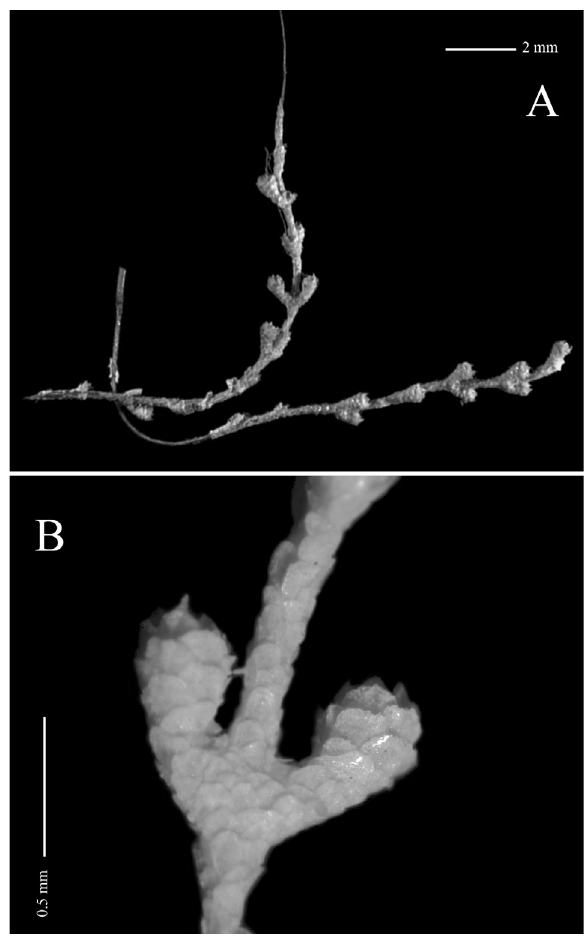
Fig . 15. – Thouarella vitjaz n. sp., holotype (IORAS IV-9- Alc-010-002): A, detail of branchlet; B, detail of a whorl of two